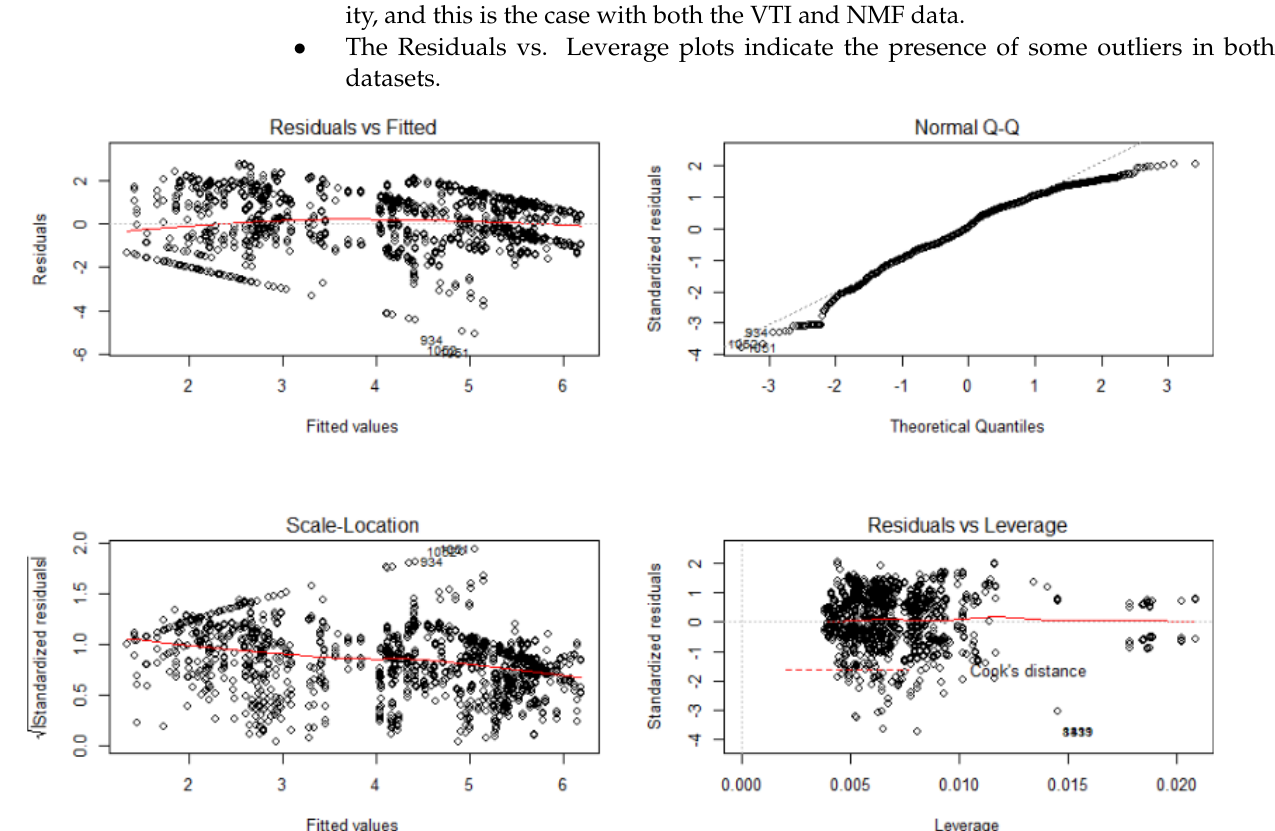
Figure 6. Checking the assumptions for logarithmic regression of the VTI